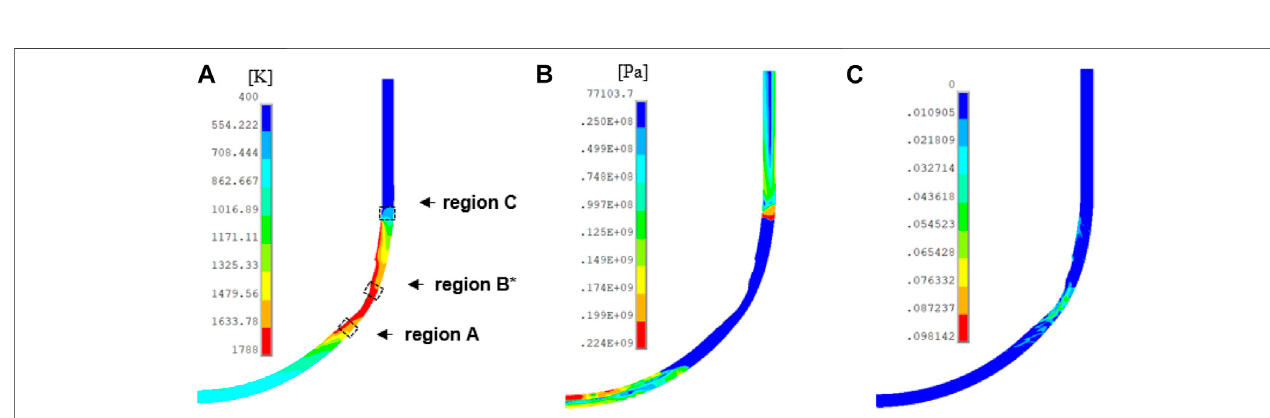
FIGURE12|(A) Temperaturedistribution(K), (B) vonMisesstressdistribution(Pa),and (C) creepstraindistributionofthevesselwallattime=7.16 hfortheSBO+ LOCA case.